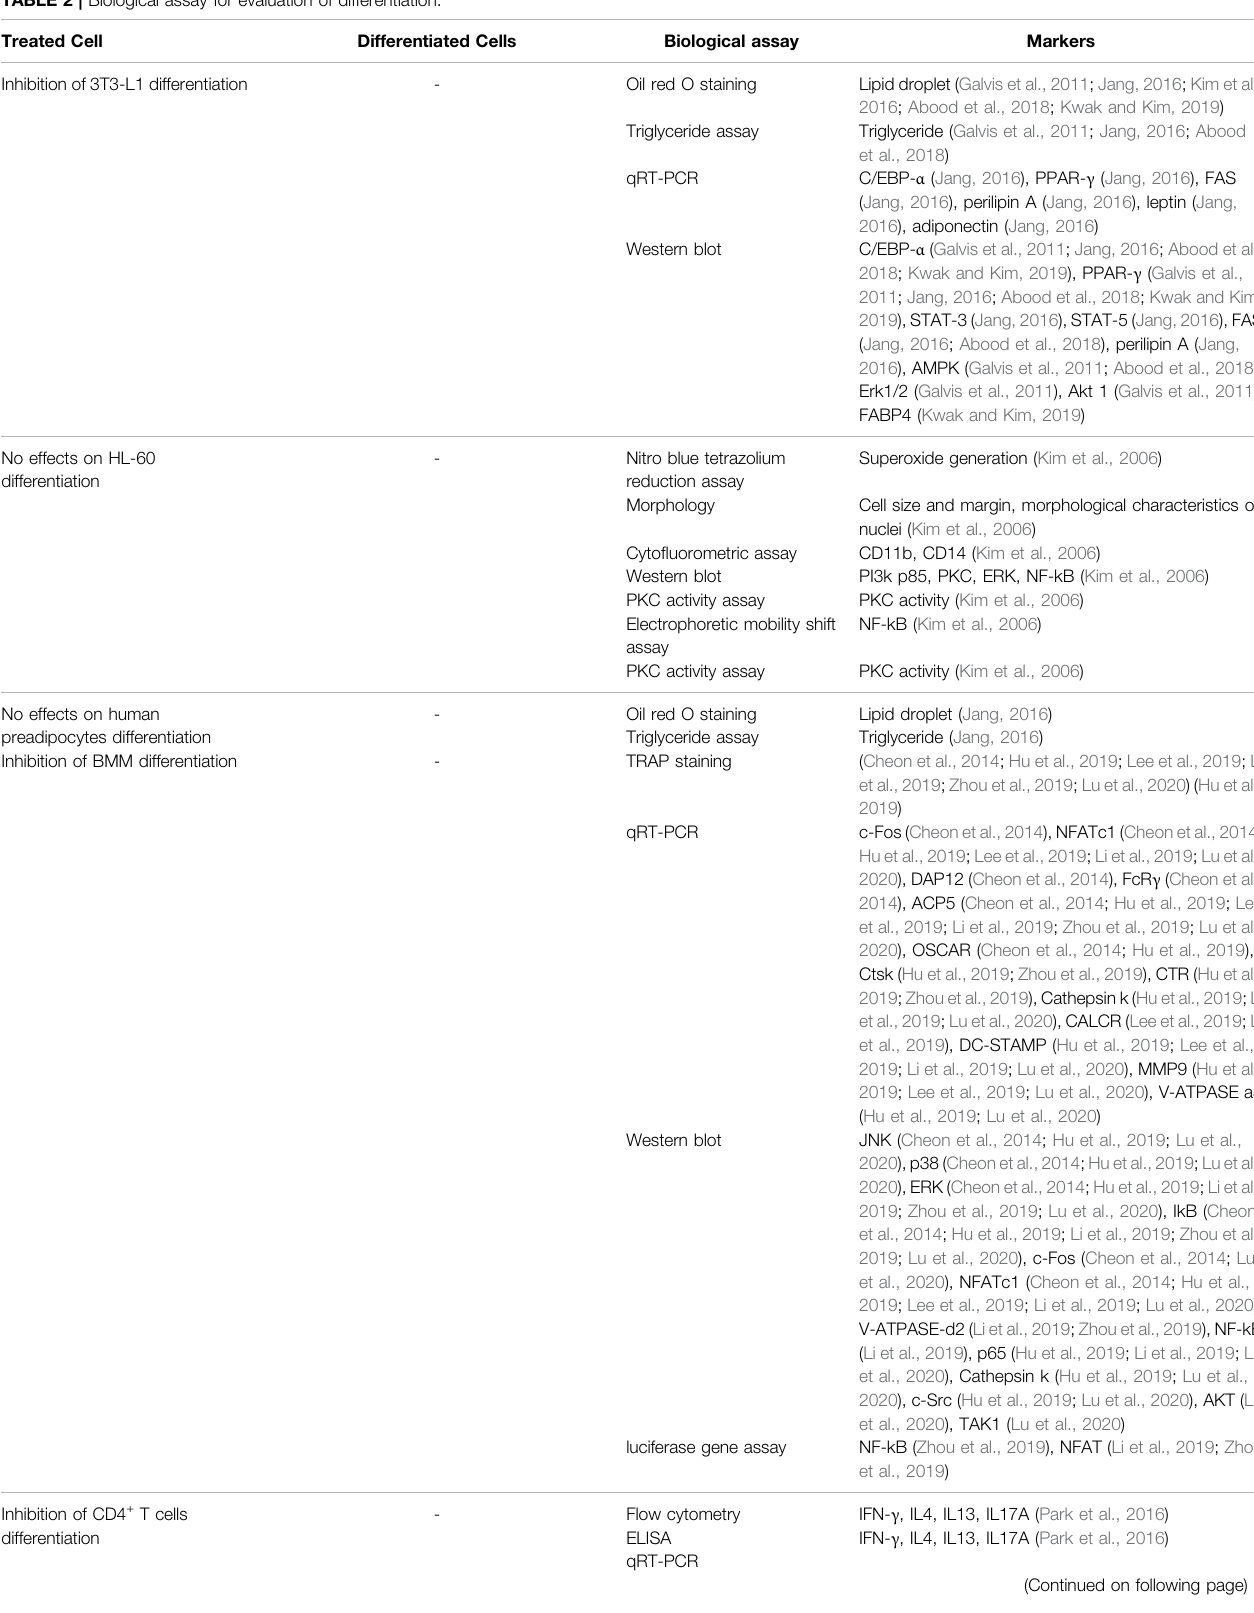
TABLE 2 | Biological assay for evaluation of